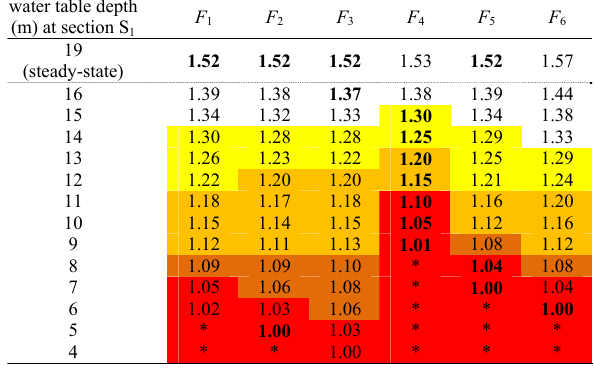
Table 3. Factors of stability ( F i ) for the considered landslide bodies (#1–6), as a function of water table depth below the ground surface (cf. Fig. 11). The minima of F i are in bold (asterisks mark values of F i < 1). The background colours mark the different levels of alarm, as listed in Table 2. water table depth (m) at section S 1